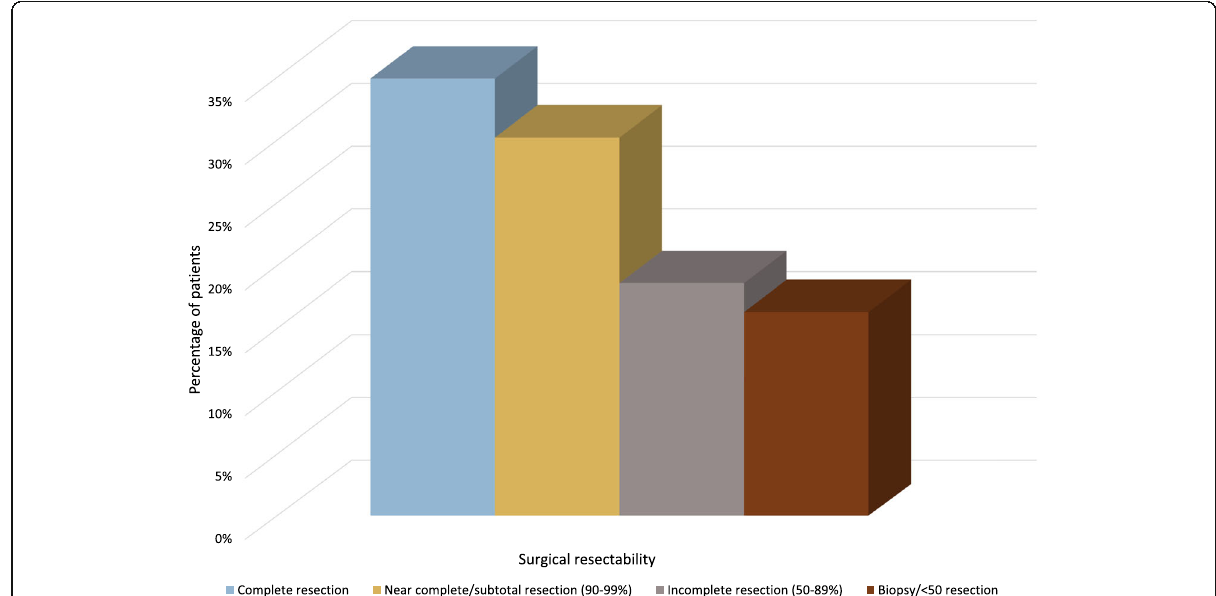
Fig. 6 The percentages of the different extents of surgical